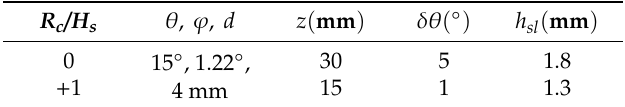
Table 2. Side lobe affected thickness ℎ 𝑠𝑙 - calculated as in Equation (5) with mean values of 𝑧 and 𝛿𝜃 (obtained from videography) for two combinations of R c /H s .